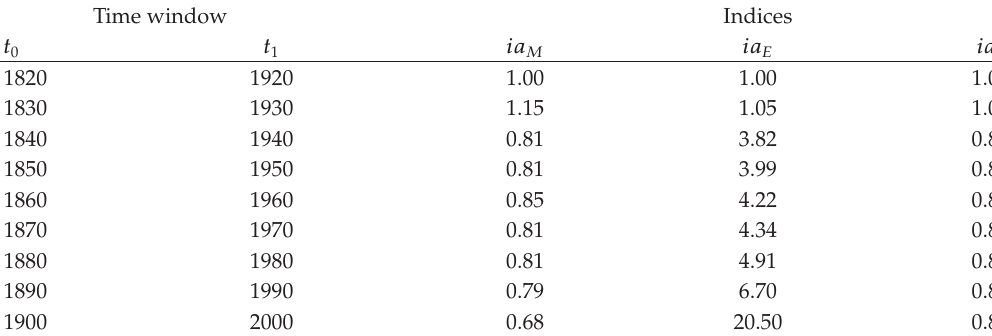
Table 3: Parameter indices from window